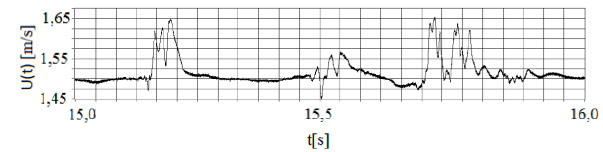
Fig. 2. Raw instantaneous velocity U(t), CTA